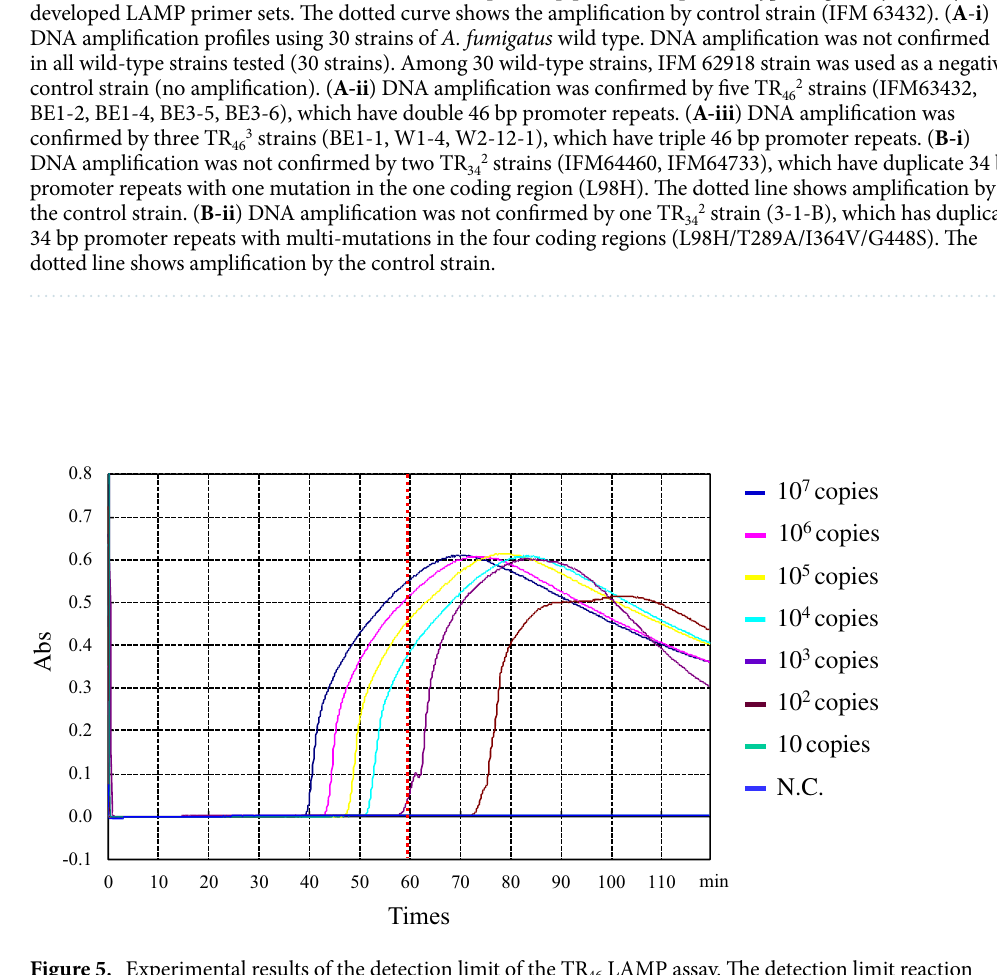
Figure 5. Experimental results of the detection limit of the TR 46 LAMP assay. The detection limit reaction was carried out using 10 7 to 10 copies of plasmid DNA per reaction. The detection limit was measured within 60